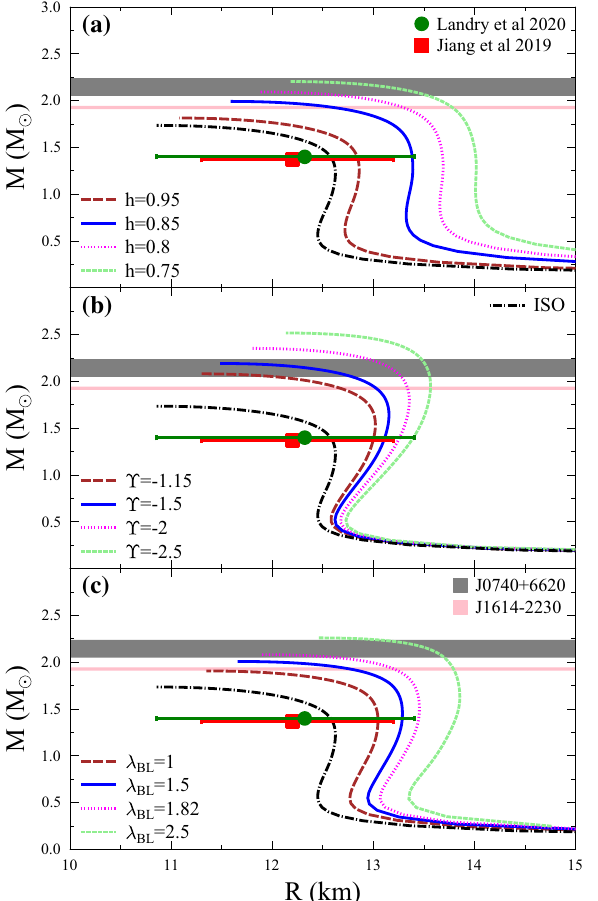
Fig. 7 Impact of anisotropic pressure on the mass–radius relation of NSs with hyperons. a For HB anisotropic model, b for DY anisotropic model, and c for BL anisotropic model. We include the constraint from the recent non-parametric study from Ref. [9], and the constraint from joint analysis of PSR J0030+0451, GW170817, and the nuclear data from Ref. [30] as well as the recent observed maximum masses of NSs, J1614 − 2230, and J0740+6620 from Refs. [1–4]. As benchmark’s, we